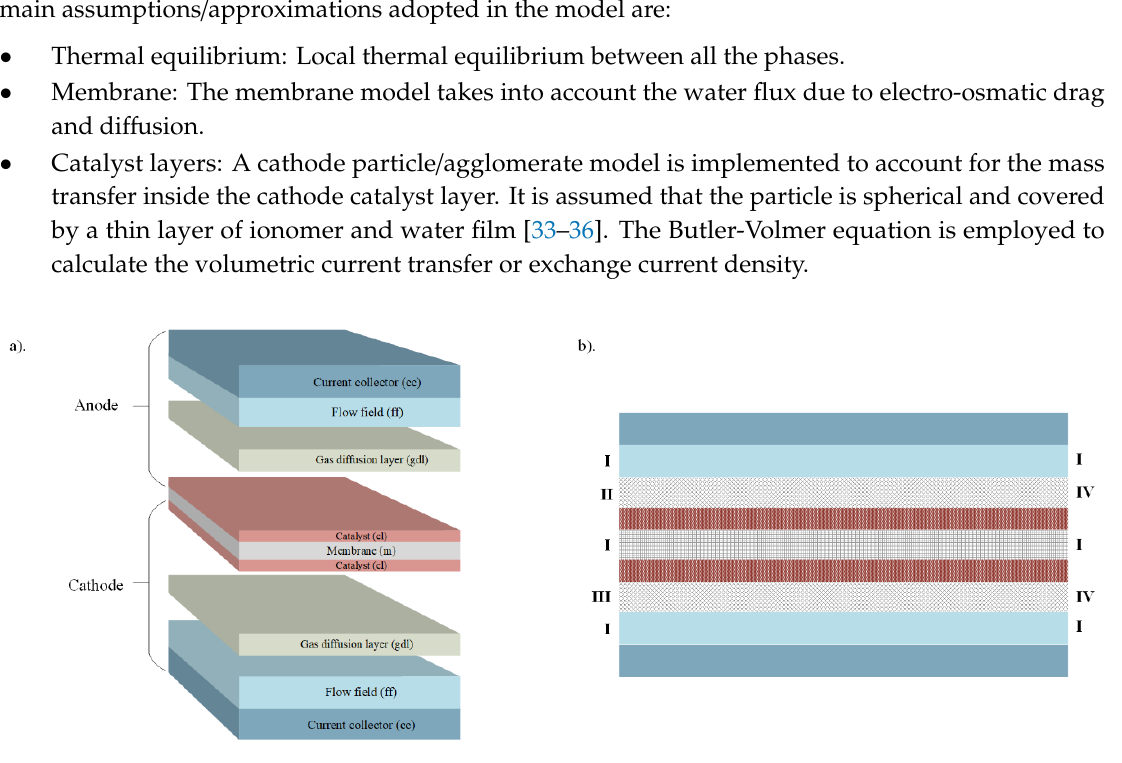
Figure 1. Schematic view of a single PEMFC: ( a ) components of PEMFC, ( b ) computational domains with boundaries: I — insulation/wall, II — anode inlet, III — cathode inlet, and IV — outlets. Table 1. Geometrical and operating parameters for two PEMFC experimental data sets.